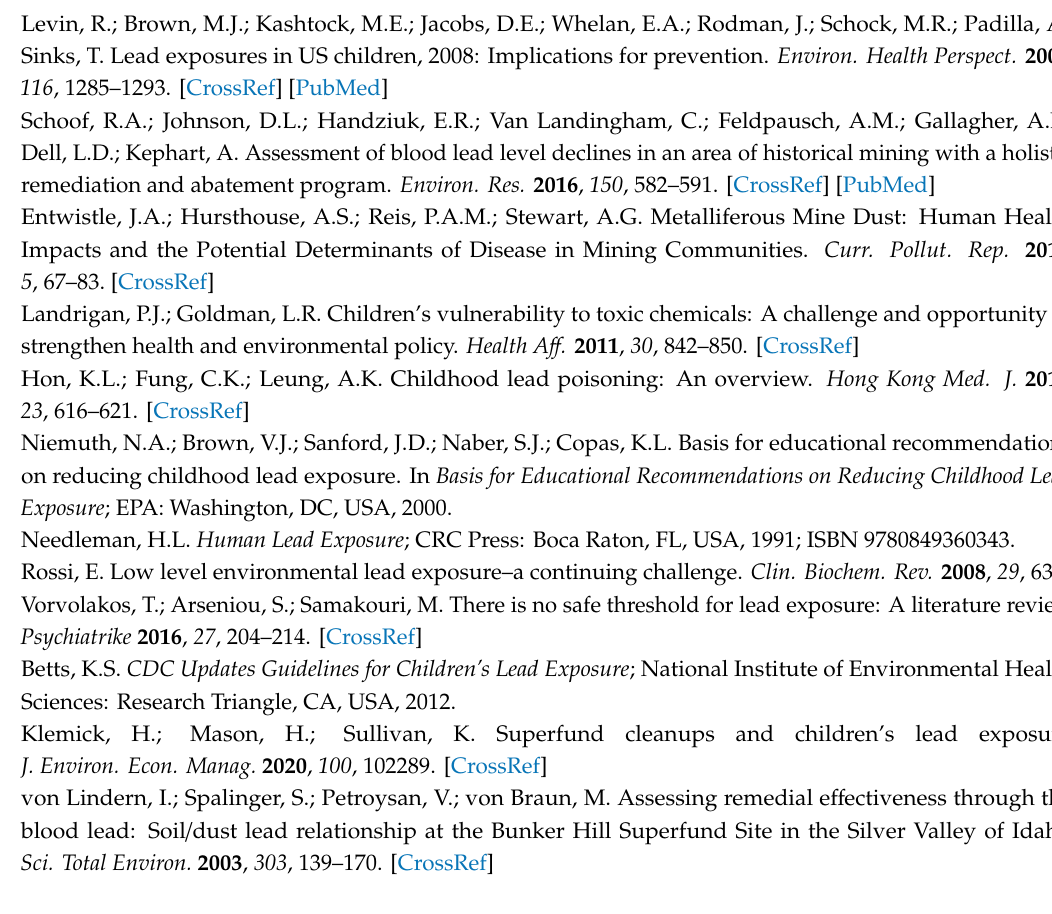
Figure S1: Survey; Table S1: Exploratory factor analysis; Table S2: Correlation